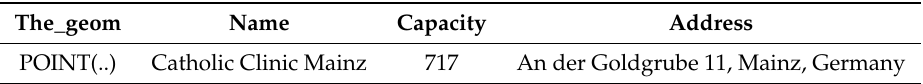
Table 5. Input data hospitals: Sample input data for hospitals provided for this experiment. The dataset includes the hospital name, its bed capacity, address along with the geometry.